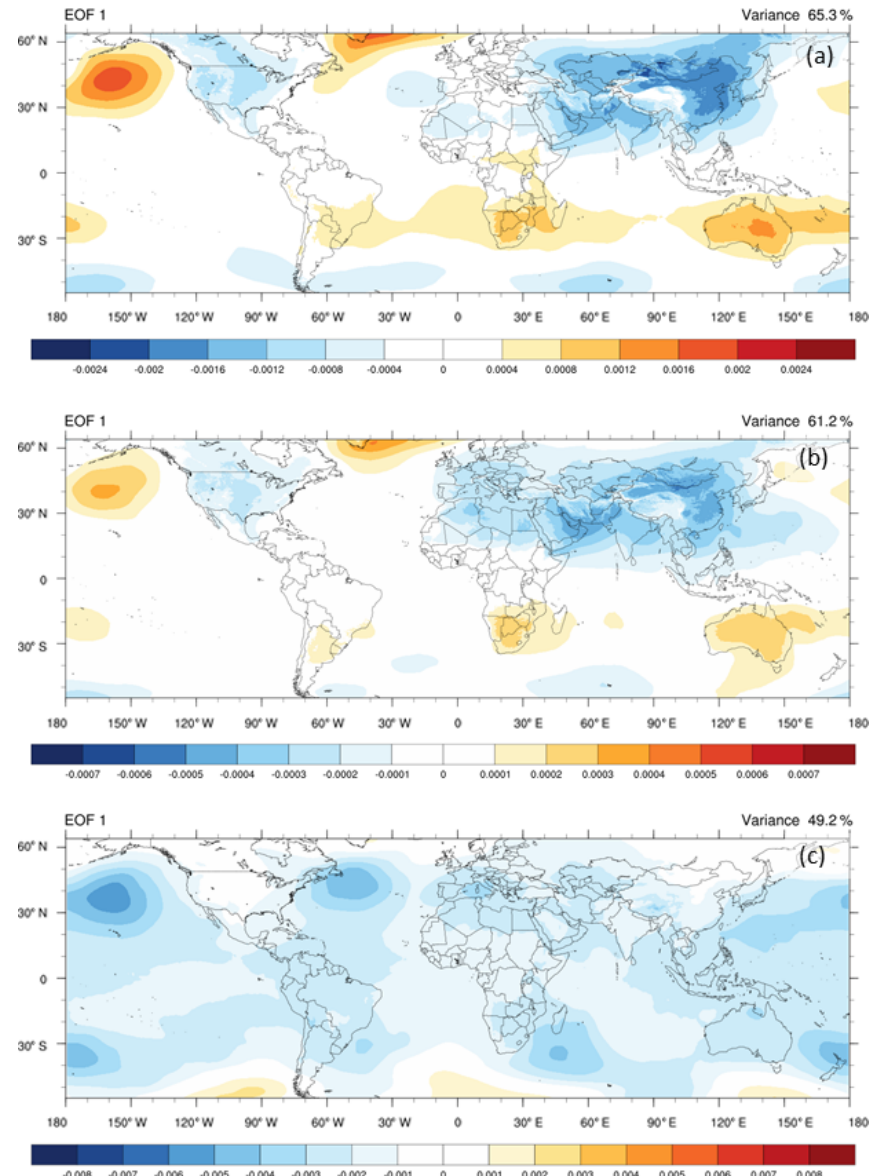
Figure 10. First EOF analyses of the monthly mean sea level pressure for the ECMWF operational analysis (a) , the CP simulation (b) , and the NCP simulation (c) over the whole forecast period. Normalized values are shown, and the averaging time steps are 00:00, 06:00, 12:00, and 18:00UTC to match the ECMWF analysis time